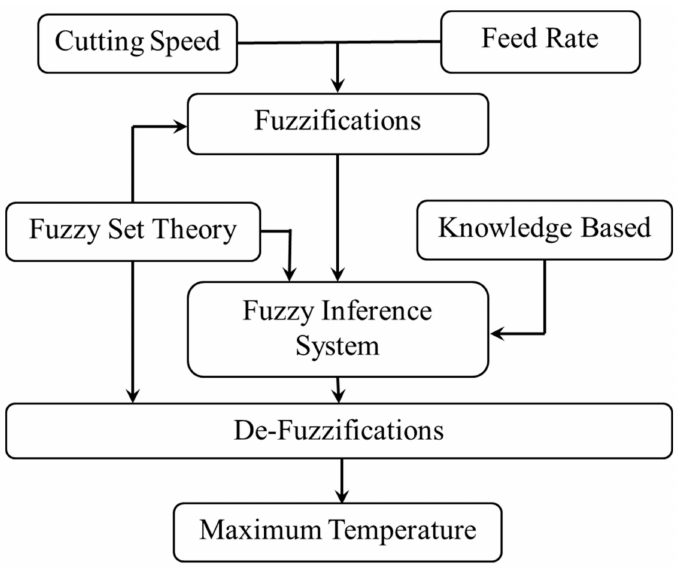
Figure 1. Schematic illustration of the developed fuzzy